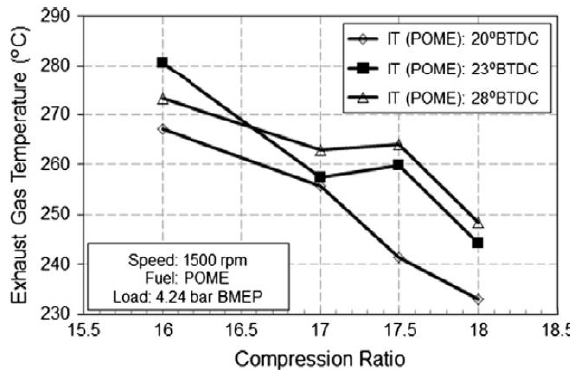
Fig. 1. Effect of injection timing and compression ratio on exhaust gas temperature; BTDC – before top dead center, POME – palm oil ethyl ester, BMEP – brake mean effective pressure